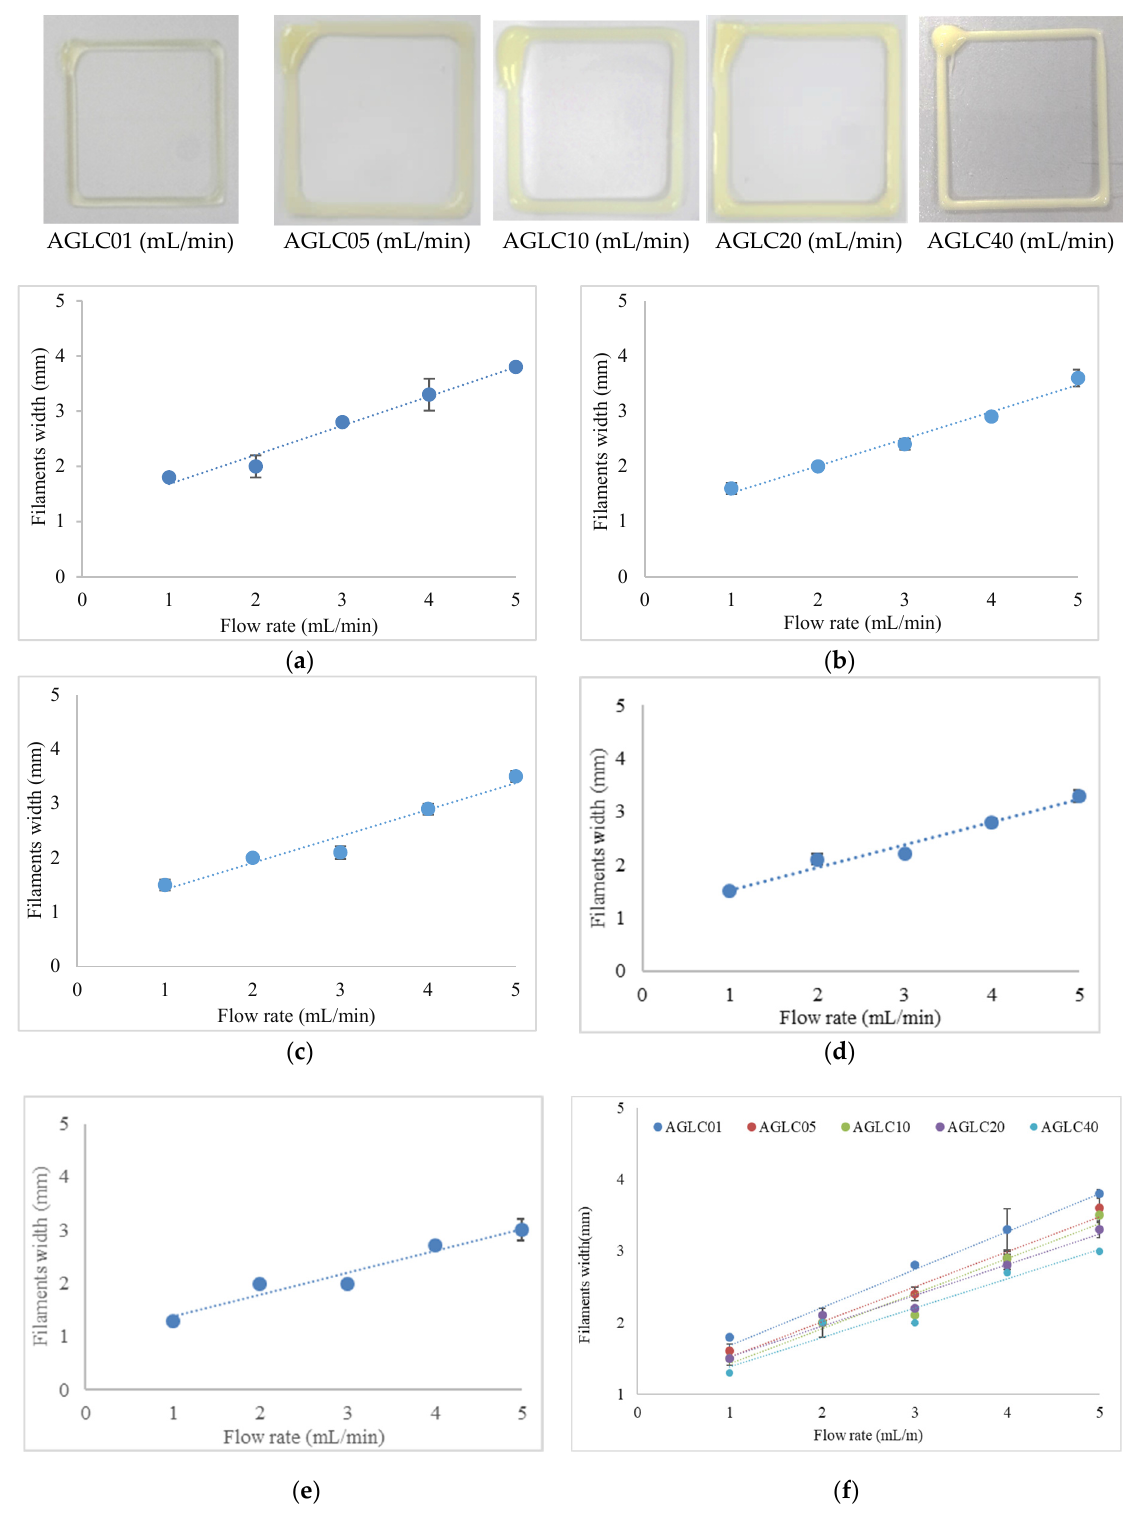
Figure 4. The relationship between the filament width to the flow rate of AGLC bioinks. ( a ) AGLC01; ( b ) AGLC05; ( c ) AGLC10; ( d ) AGLC20; ( e ) AGLC40; ( f ) AGLC bioinks. ( b ) AGLC05; ( c ) AGLC10; ( d ) AGLC20; ( e ) AGLC40; ( f ) AGLC